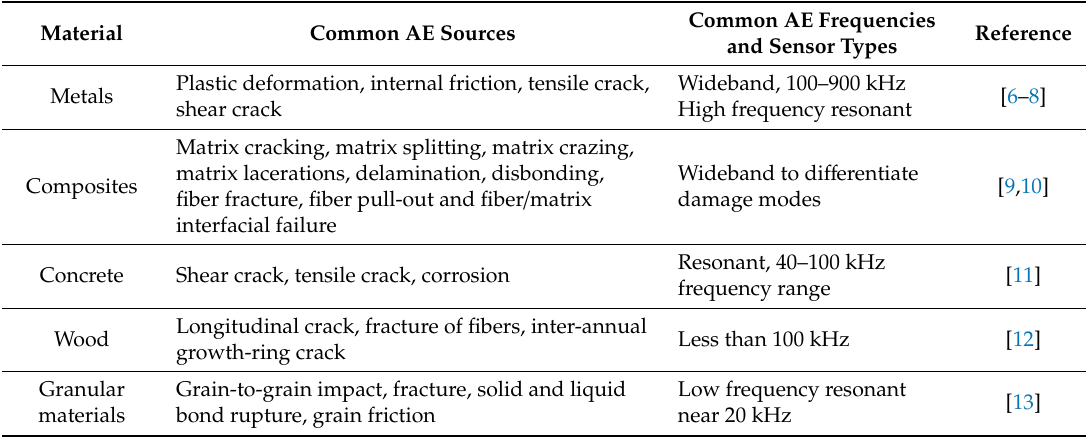
Table 1. Common AE sources in solids and typical AE sensors